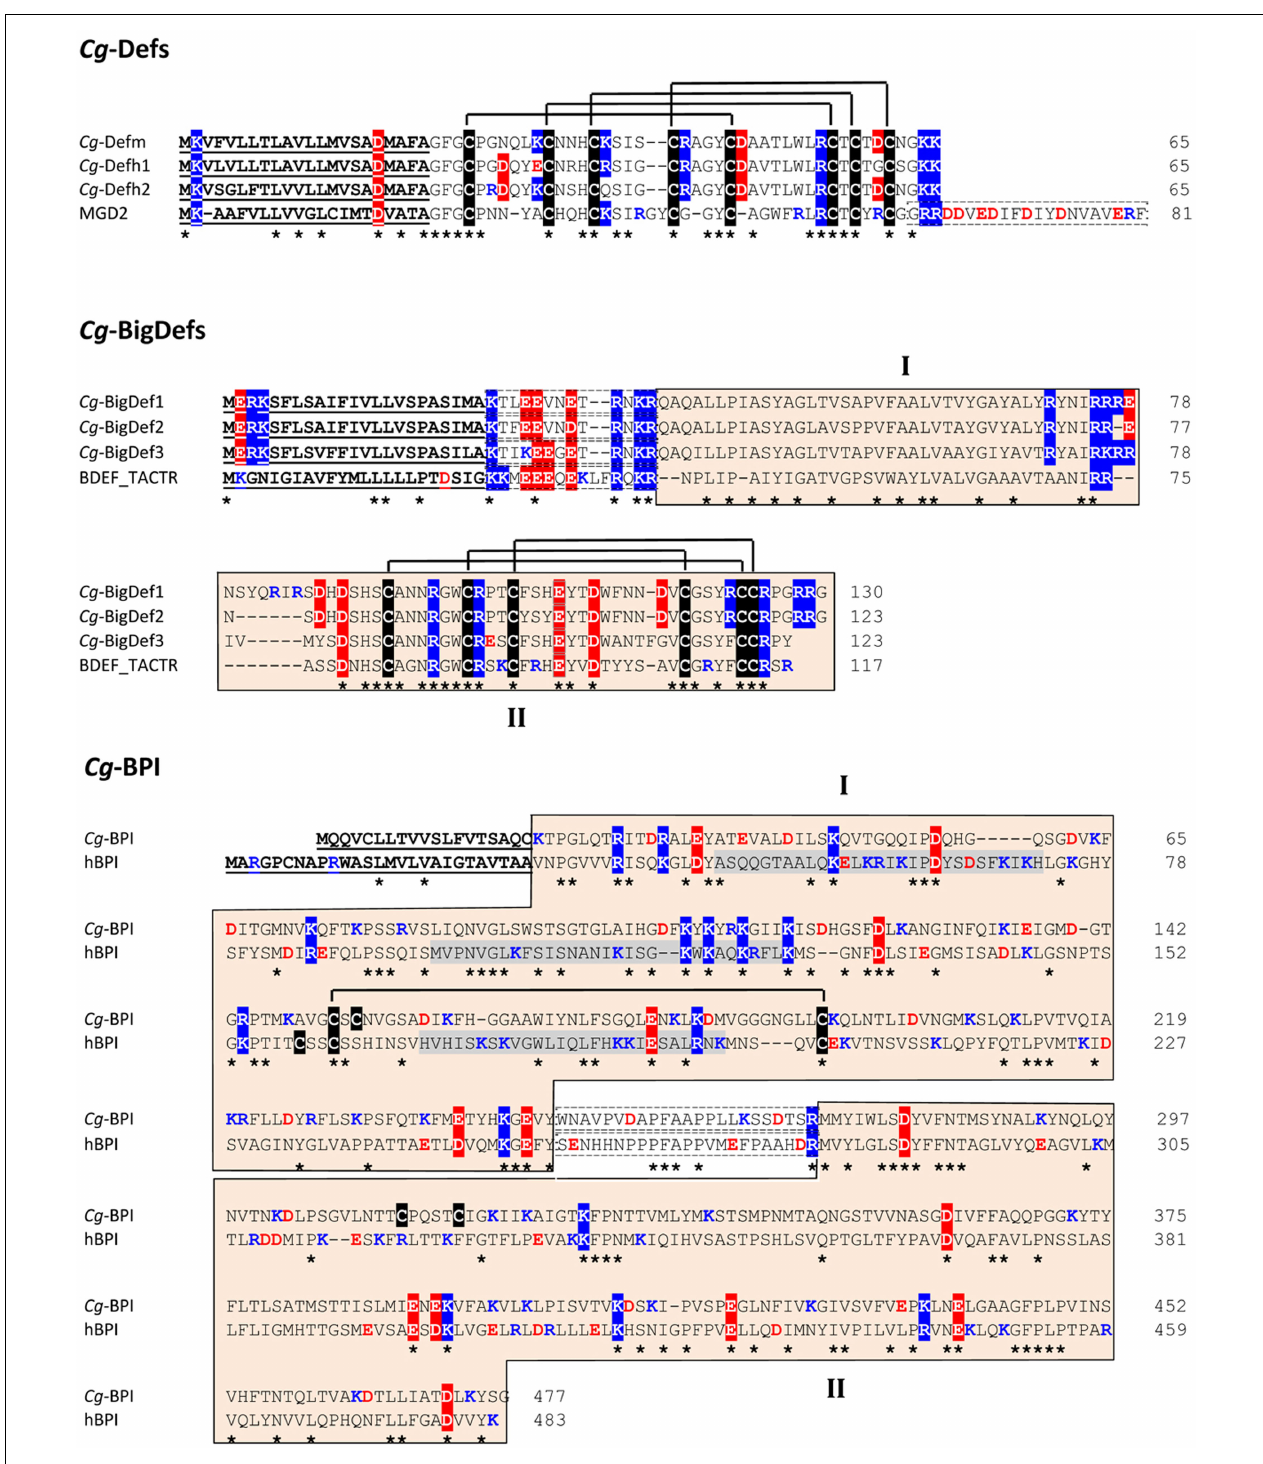
amino acid sequences displayed here for Cg -Defm, Cg -Defh1, and Cg -Defh2 correspond to GenBank AJ565499, ACQ73009, and ACQ76280, respectively. The cysteine array is based on the 3D structure of Cg- Defm (PDB: 2B68). Cg-BigDef precursors are composed of a predicted signal peptide